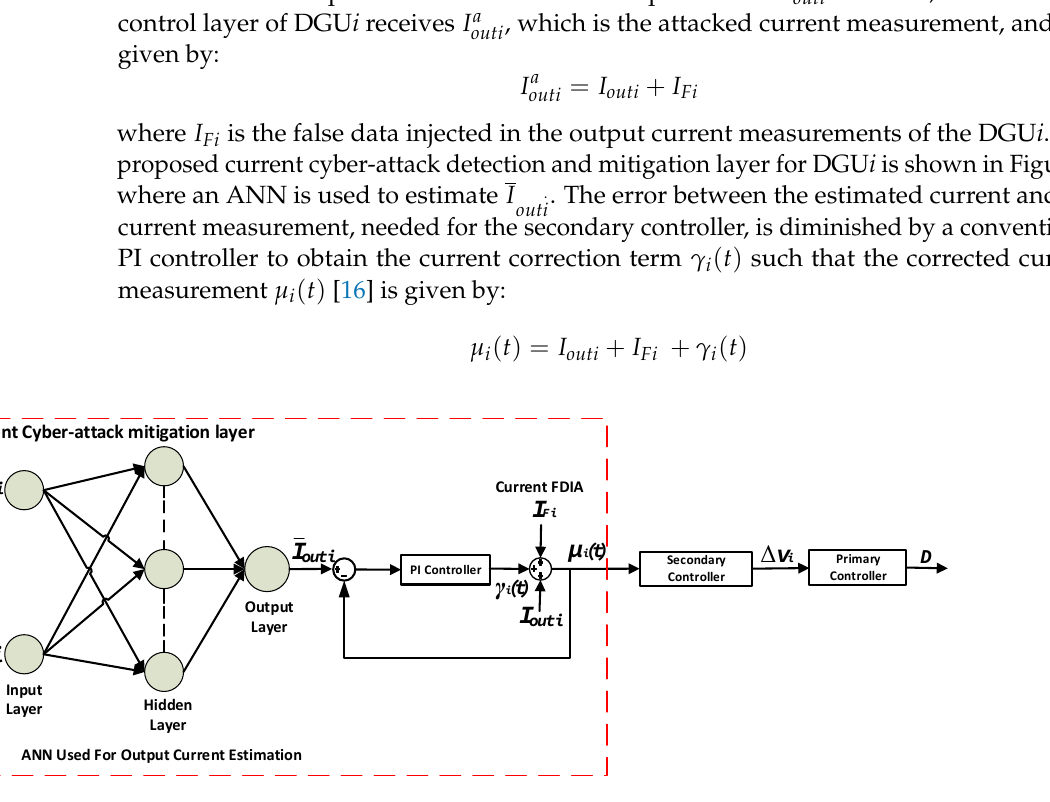
Figure 5. Current cyber-attack detection and mitigation layer proposed for the secondary controller of DGU i .